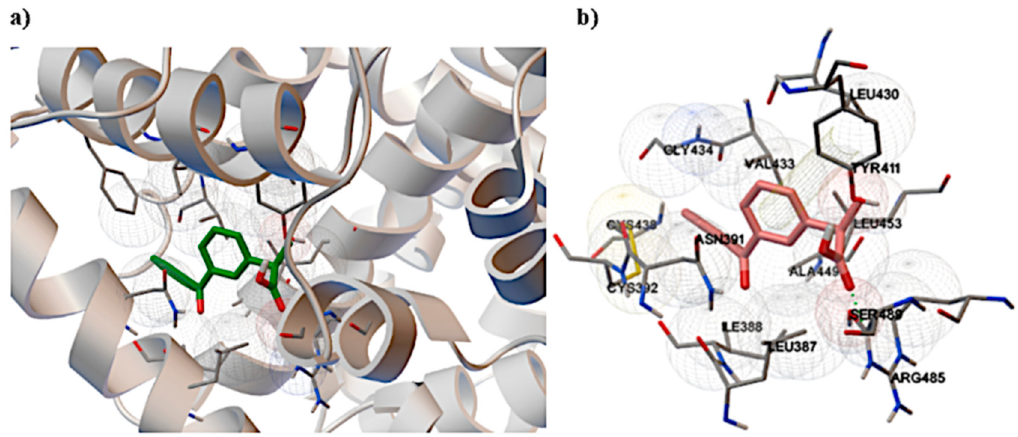
Figure 5. Ketoprofen docked into the Sudlow II site in HSA by AutoDock.